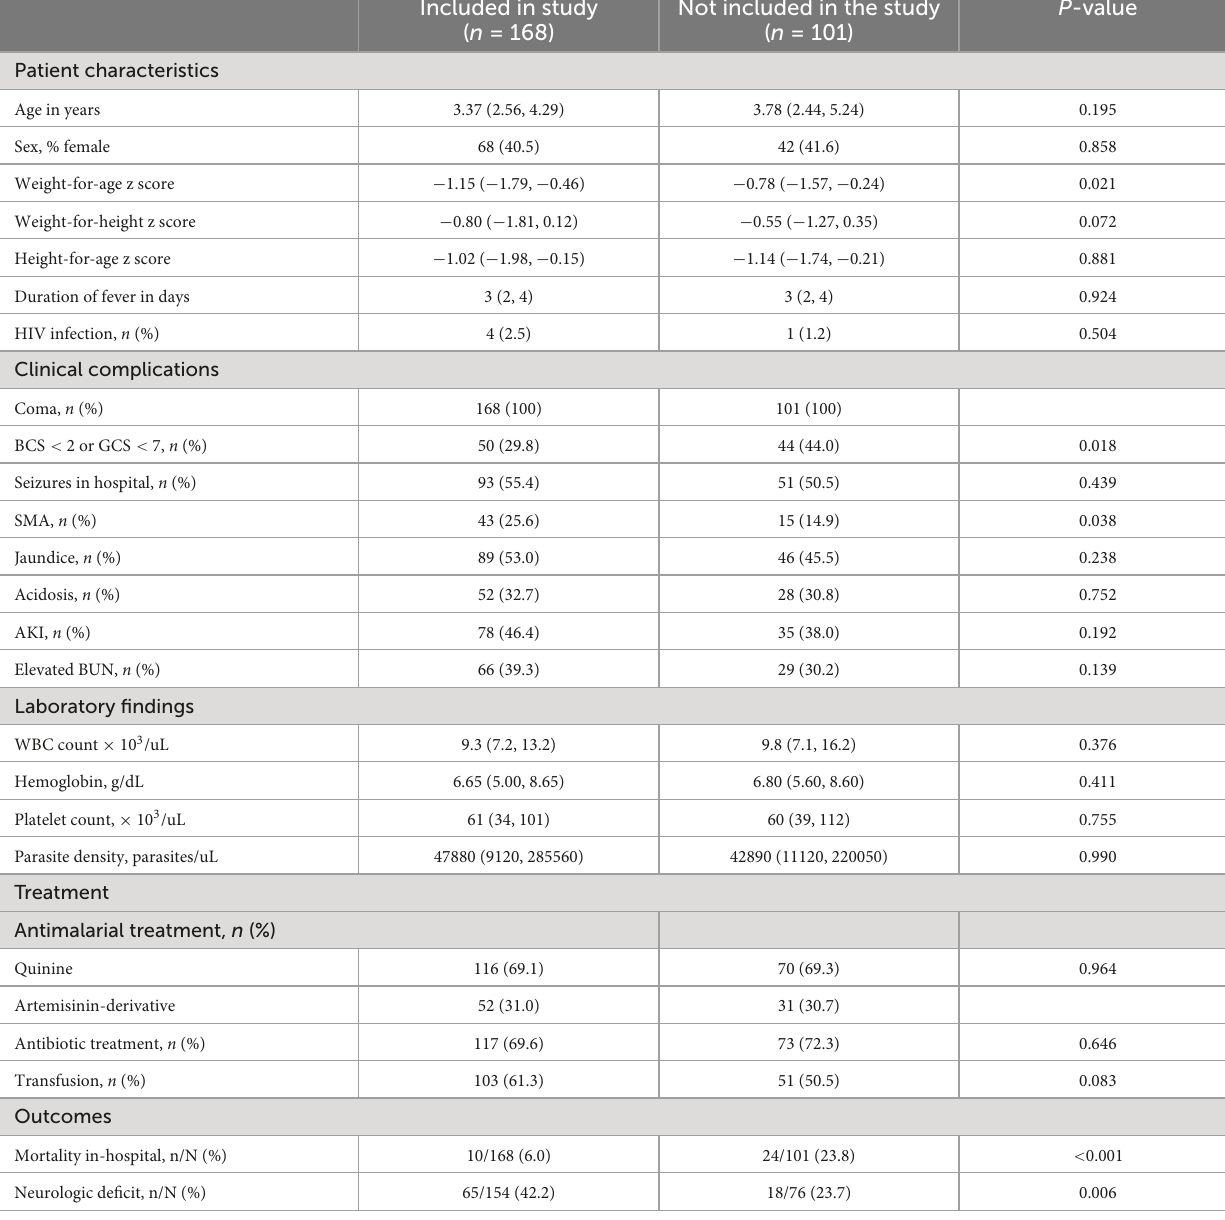
TABLE 1 Children with cerebral malaria for the